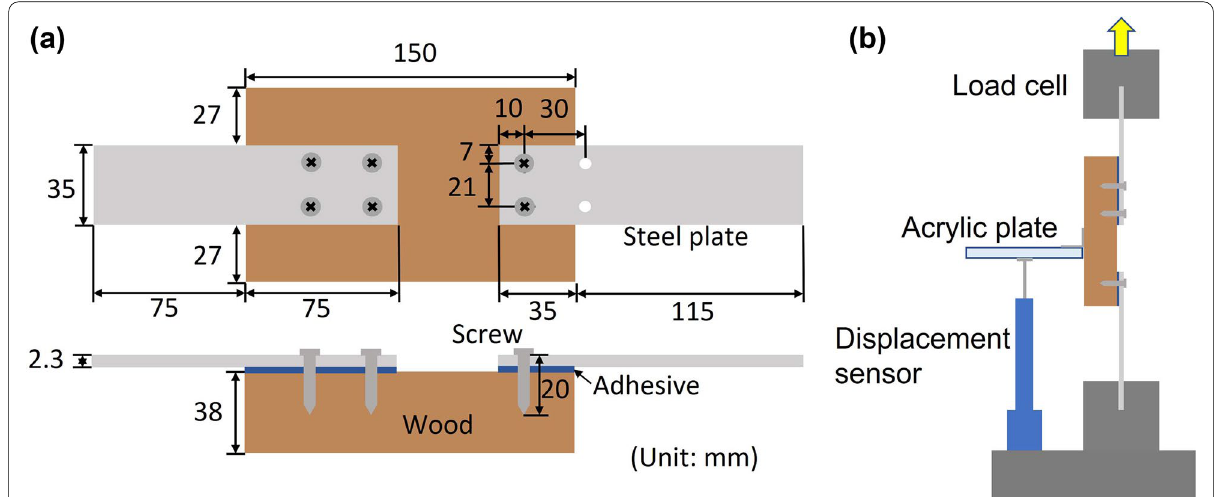
Fig. 1 a Specimen geometry and b experimental setup for lap-shear